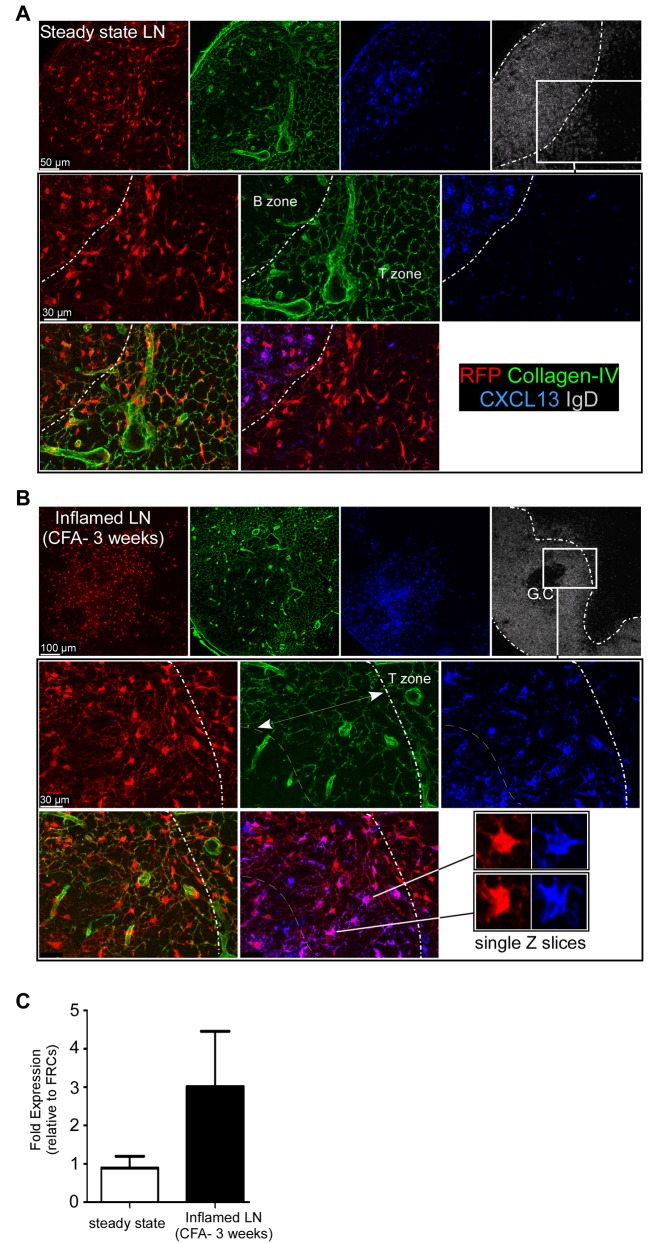
Induction of CXCL13 secretion in CD21− RFP+ stromal cells upon B cell follicle enlargement.CD21cre-RFP chimeras were untreated (A) or injected (B) with an emulsion of CFA/PBS in the ears. Three weeks later, ear draining LNs were sectioned, stained for collagen IV (green), IgD (white), and CXCL13 expression (blue), and imaged by confocal microscopy. RFP+ cells appear in red. Inserts display high magnifications of the boundaries between T and B cell areas (dashed line). In (B), the arrow indicates the area of the enlarged B cell follicle covered by the collagen IV network (conduit system). Single z slices show intracellular staining of CXCL13. (C) CXCL13 mRNA levels in CD21− CD45− RFP+ cells purified from resting and CFA-inflamed LNs relative to FRCs. Data are representative of three different experiments (two mice (A and B) and five mice (C) per experiment).